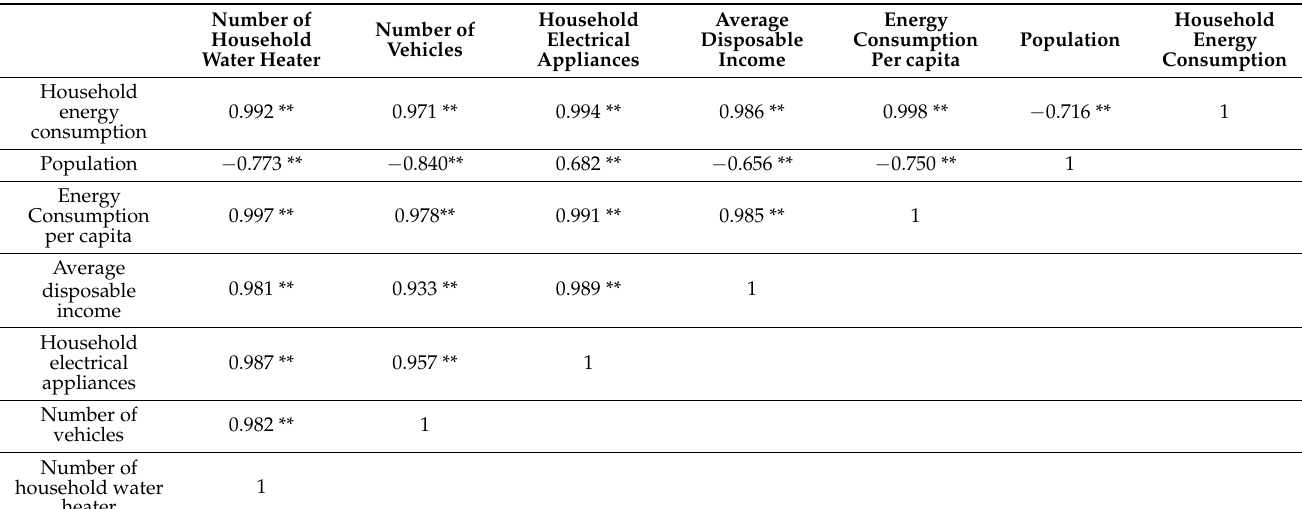
Table 1. Analysis of factors influencing rural household energy use in Guangdong.